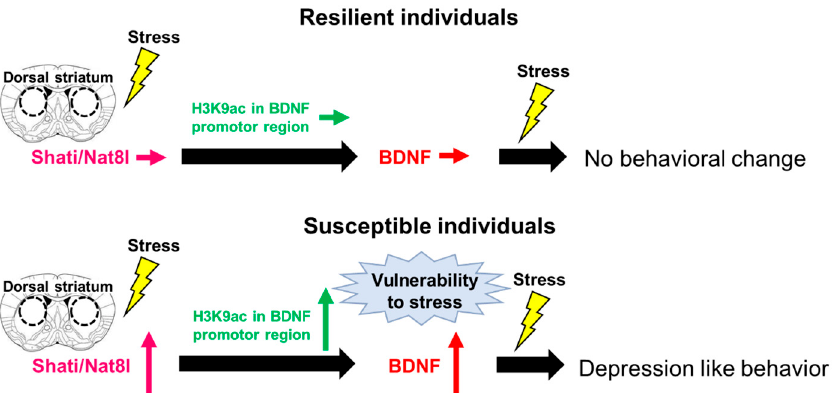
Figure 2. The Shati/Nat8l-BDNF pathway in the dorsal striatum determines stress sensitivity. A model summarizing the determination of stress sensitivity by the dorsal striatal Shati/Nat8l-BDNF pathway: resilient mice do not show the upregulation of Shati/Nat8l and BDNF expression by chronic social stress; thus, vulnerability to stress is not established and subsequent stress does not induce depression-like behaviors. Susceptible mice show upregulation of Shati/Nat8l and BDNF expression by chronic social stress, resulting in the establishment of a vulnerability to stress, in which subsequent stress contributes to depression-like behaviors.